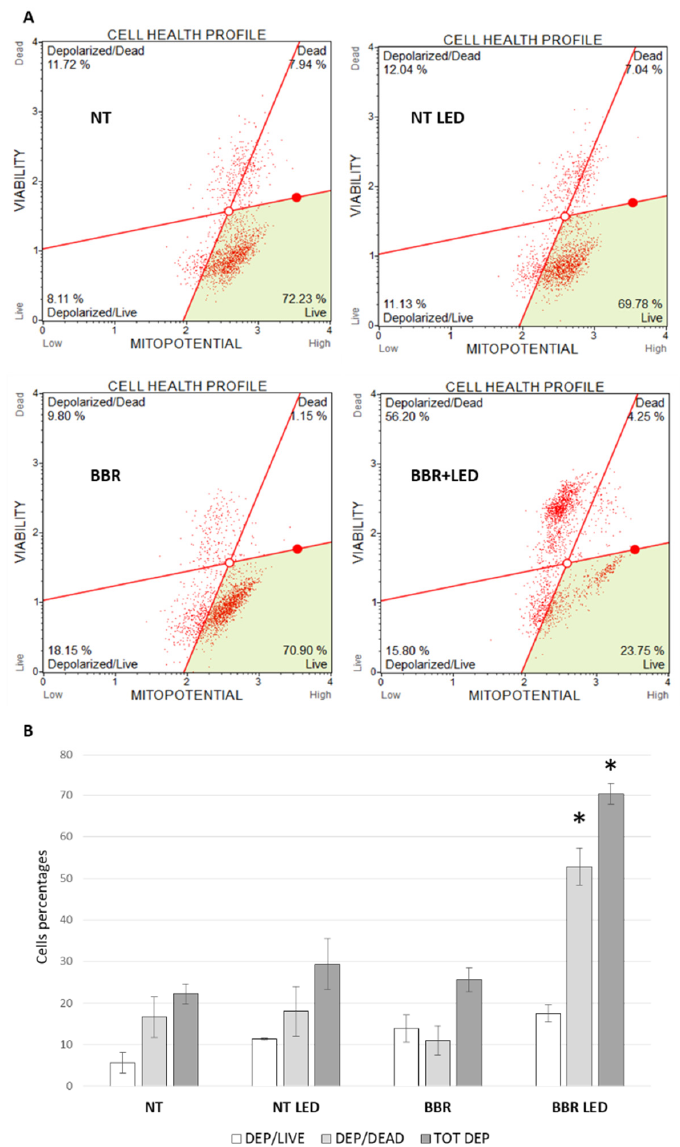
Figure 11. Mitochondria depolarization analysis. Cytofluorimetric analysis of mitochondria depolarization in T98G cells as untreated (NT), exposed to LED stimulation (LED), BBR (200 μ g/mL for 4 h) administration and with the combined LED+BBR scheme, evaluated after 24 h p.t. ( A ). Trypsinized cells were analyzed for count of live and dead depolarized percentage of cells using the Muse MitoPotential kit (Luminex). The histogram of the averages of two replicas of cells percentage is reported ( B ). Asterisks indicated statistical significance compared to untreated cells ( p < 0.05, Anova